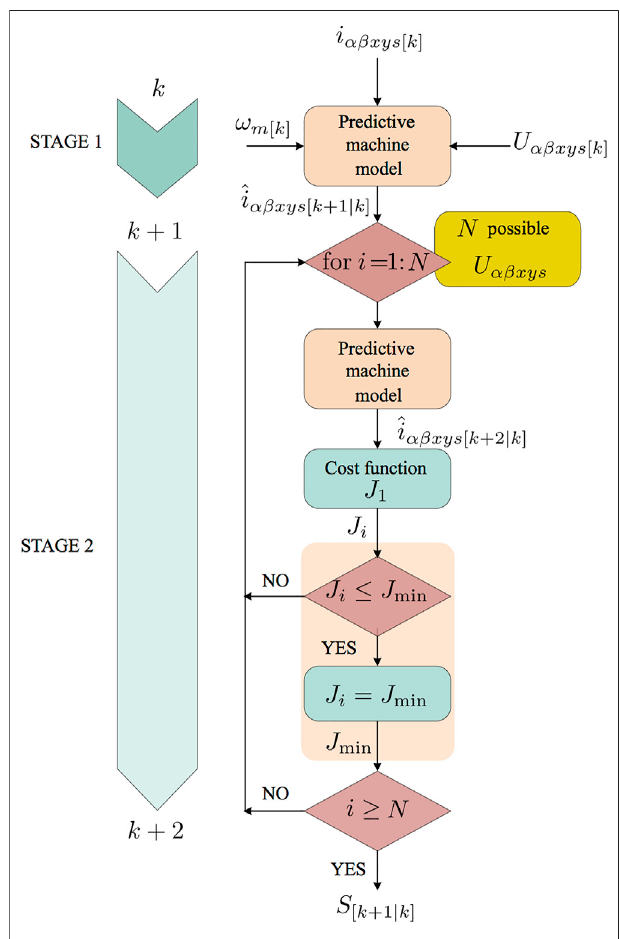
FIGURE 7 | MPC fl owchart for a multiphase electric